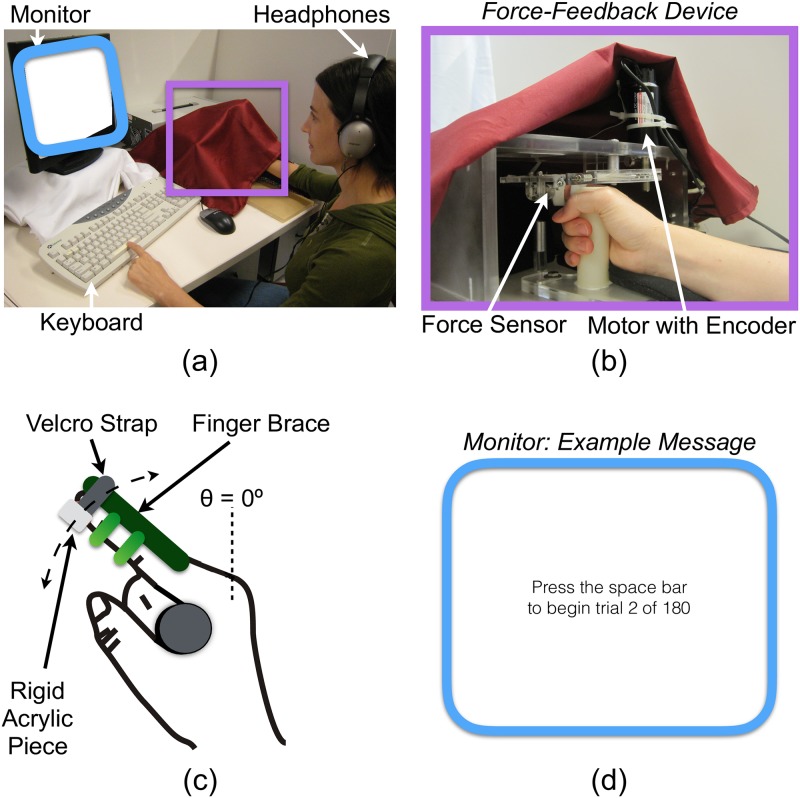
Experimental setup.(a) Experimental setup: The participant wears noise-canceling headphones that mask auditory distractions and provide experimental cues. The computer monitor displays trial-related commands to the user throughout the testing. The custom force-feedback device and the participant’s right hand are hidden by a red cloth during experimentation, and the participant presses keys with the left hand to provide trial-related feedback. (b) Force-feedback device: The participant rotates the right index finger about the metacarpophalangeal joint, and a motor with encoder applies a force to and measures the angular position of the participant’s finger. A force sensor measures interaction forces. (c) User interaction: The participant grasps a cylindrical tube with the right hand and presses on a rigid acrylic disk attached to the force-feedback device using the center of the right index finger’s distal finger pad. The participant wears a finger brace on the right index finger, and this finger is attached to the force-feedback device via a velcro strap that connects to the rigid acrylic piece. (d) Sample message: The monitor displays messages to instruct participants how to proceed throughout the trials. Images are adapted from Fig 1 of [27] © IEEE, and the participant shown in this figure provided written informed consent (as outlined in the PLOS consent form) to publish this photo.